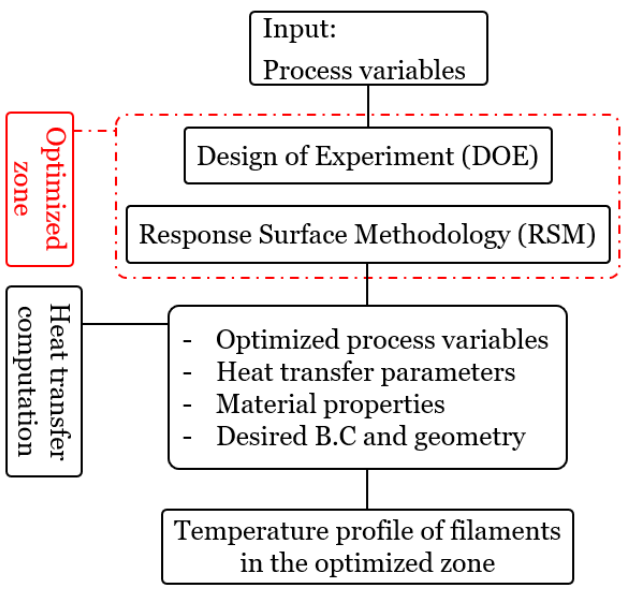
Figure 2. General flowchart of the proposed approach in this study.